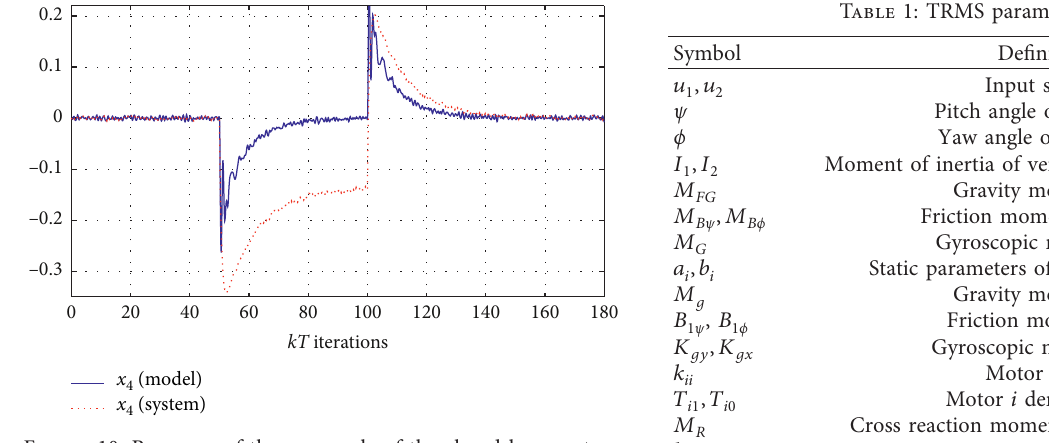
Figure 10: Response of the yaw angle of the closed-loop system.